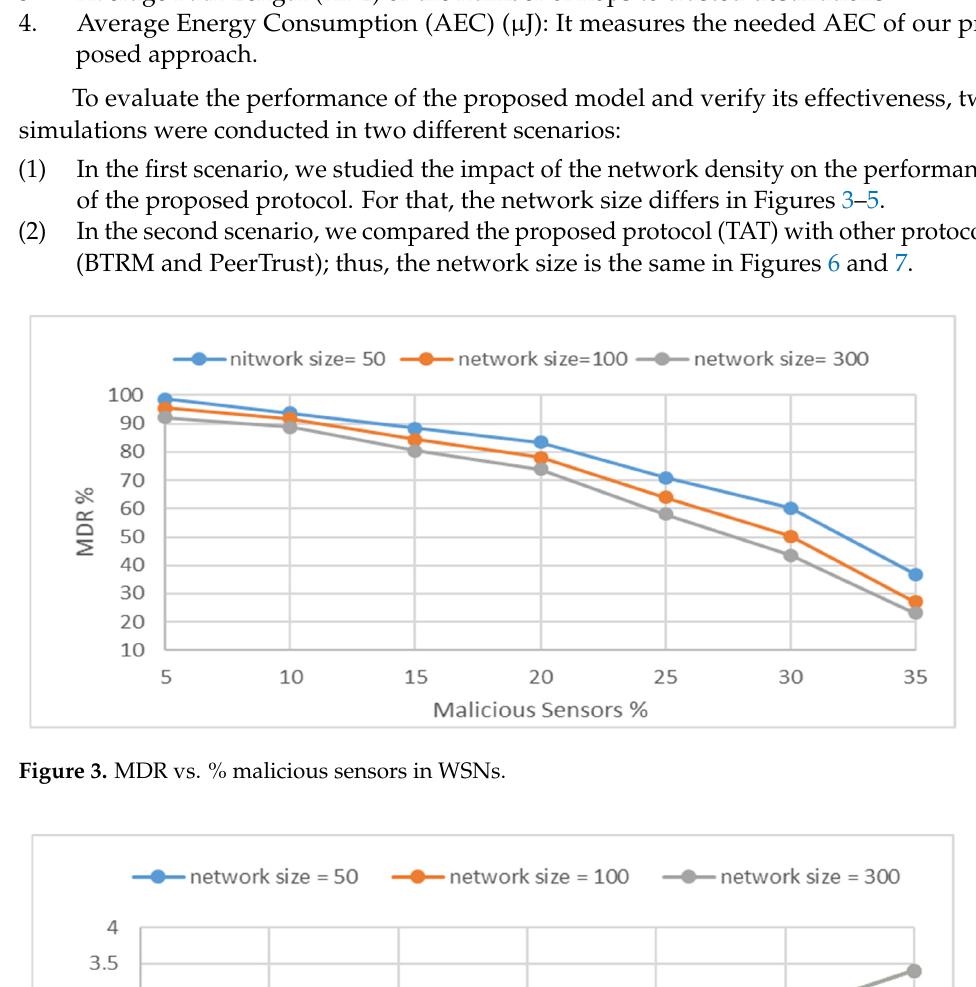
Figure 4. SD% vs. % malicious sensors in WSNs.